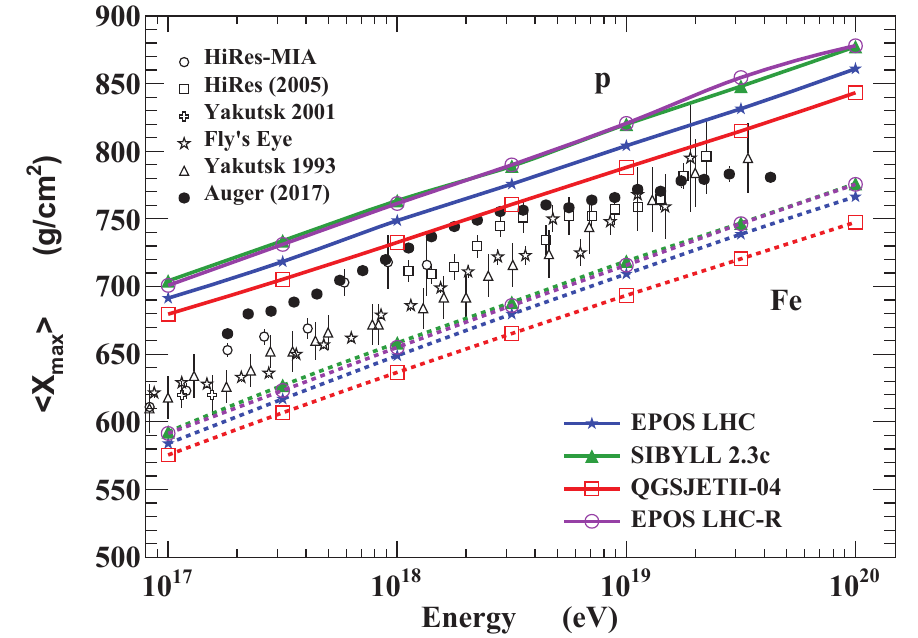
Figure 4. (cid:3) X max (cid:4) for proton- and iron-induced showers as a function of the primary energy. Predictions of di ff erent high-energy hadronic interaction models are presented with full lines for proton and dashed lines for iron with full triangles for S ibyll 2.3d, open circles for E pos LHC-R, open squares for QGSJ et II.04, full stars for E pos LHC. Refs. to the data can be found in [32] and